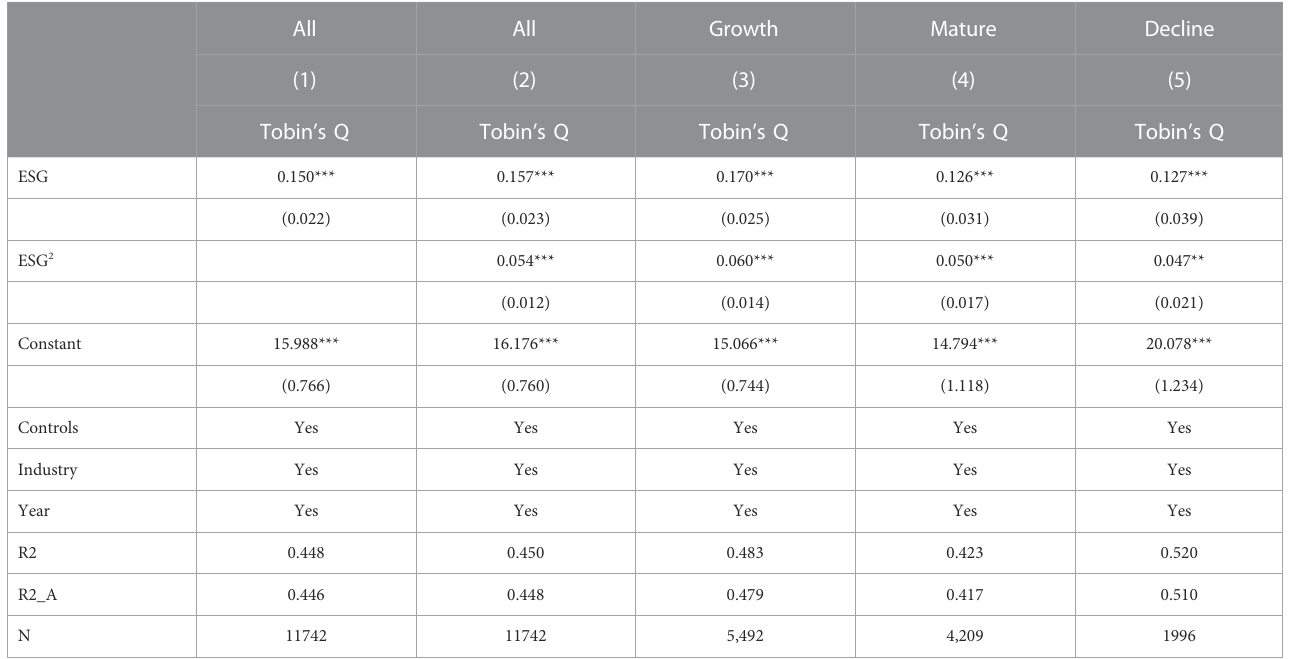
TABLE 14 Non-linear test